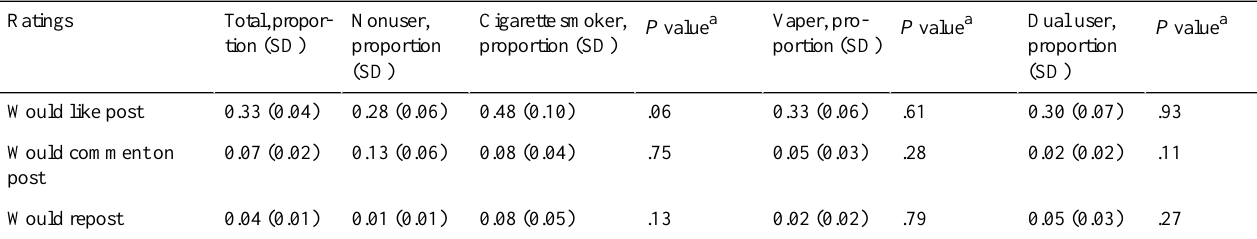
Table 2. Ratings of the posts by smoking